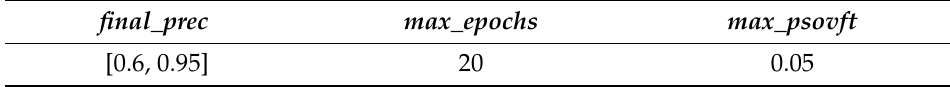
Table 2. Thresholds for the feature pruning criteria.